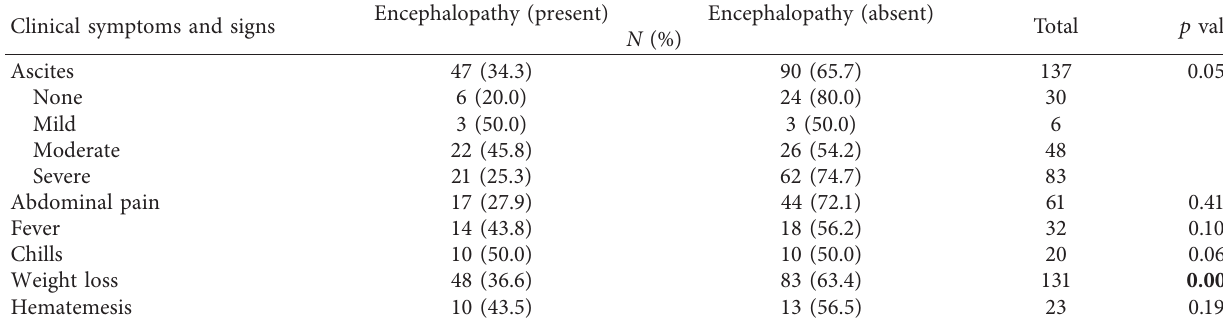
Table 5: Clinical features of the study participants.